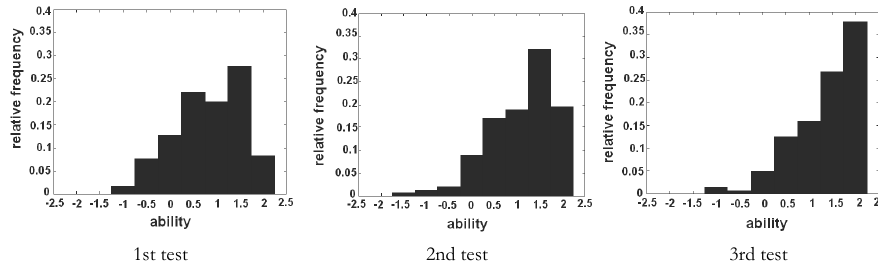
Figure 5 – Histogram of estimated abilities in the three